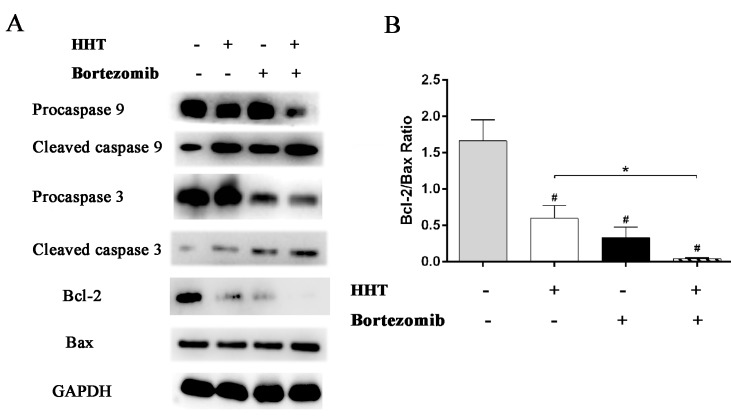
Effects of HHT and Bortezomib on caspases and Bcl-2 family proteins.HHT and Bortezomib simultaneously actived caspase 9 and caspase 3, induced the up-regulation of Bax protein and the down-regulation of Bcl-2 protein after 72 h exposure. *P < 0.05, #P < 0.01 vs untreated control.